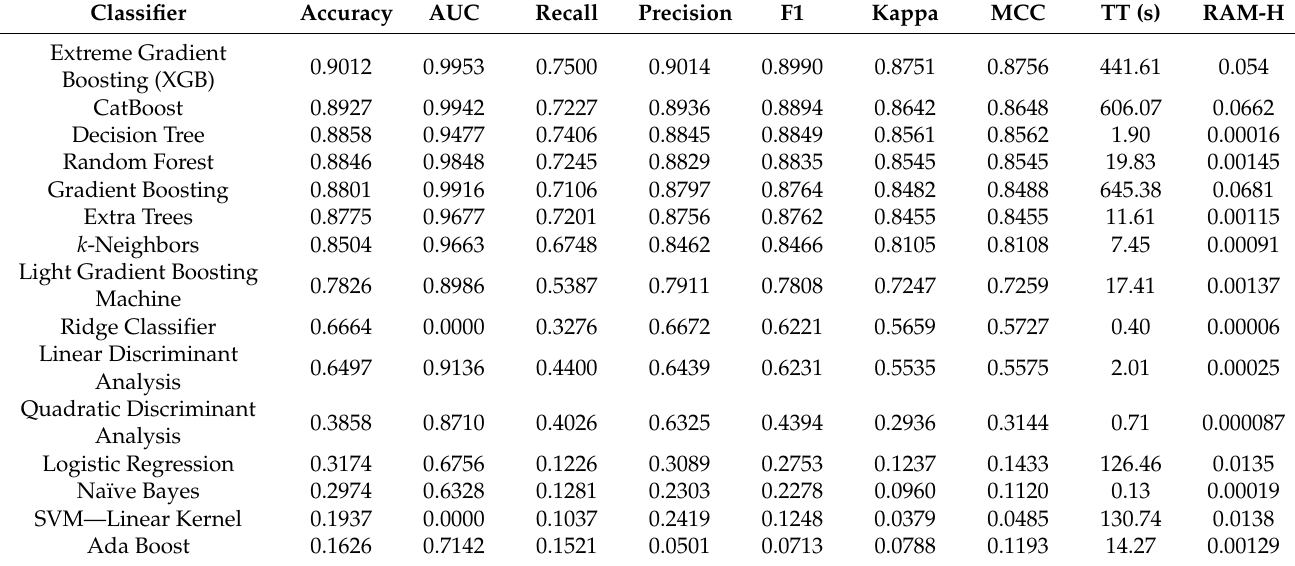
in the green squares and the low numbers of incorrect responses in the light green